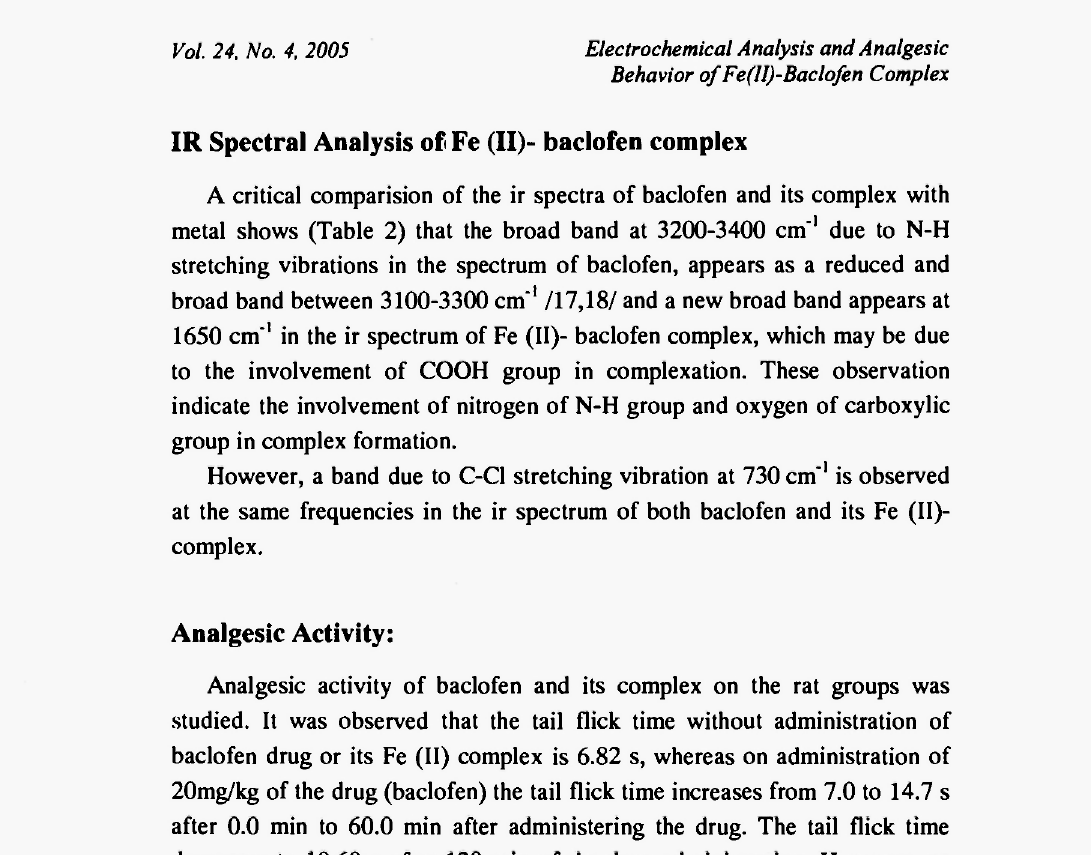
Principal IR signals (cm 1 ) and their assignments for baclofen and its Fe (II)